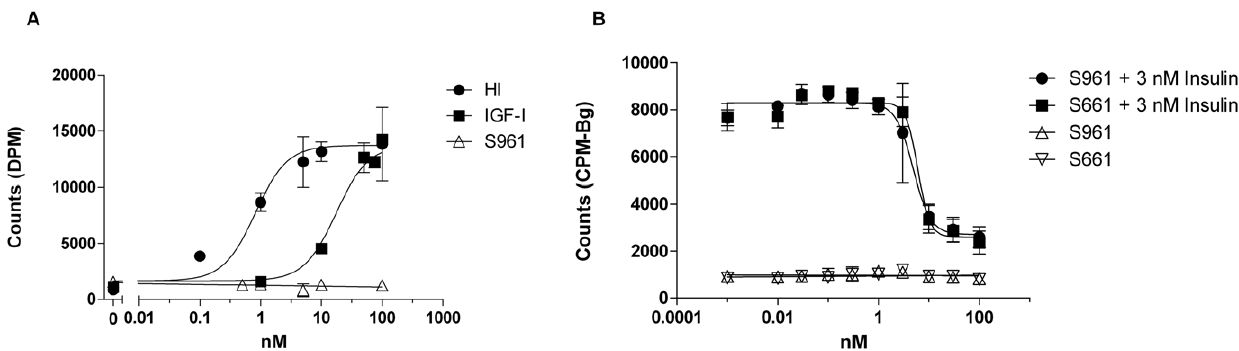
Figure 4. S961 did not stimulate glycogen synthesis in differentiated adipocytes or in muscle cells. A , Differentiated 3T3-L1 adipocytes were stimulated with increasing concentrations of HI, IGF-I or S961. The graph is representative of two independent experiments each comprising duplicate determinations. Error bars show one standard deviation. B , L6-hIR muscle cells were stimulated with increasing concentrations of S961/ S661 alone or in combination with 3 nM insulin. The graph is representative of two independent experiments each comprising triplicate determinations. Error bars show one standard deviation.